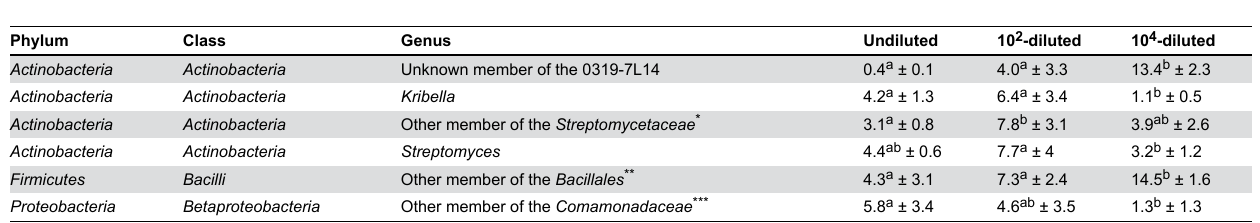
Table 3. Relative abundance (%) of abundant genera (> 1% of total reads) detected as significantly different between